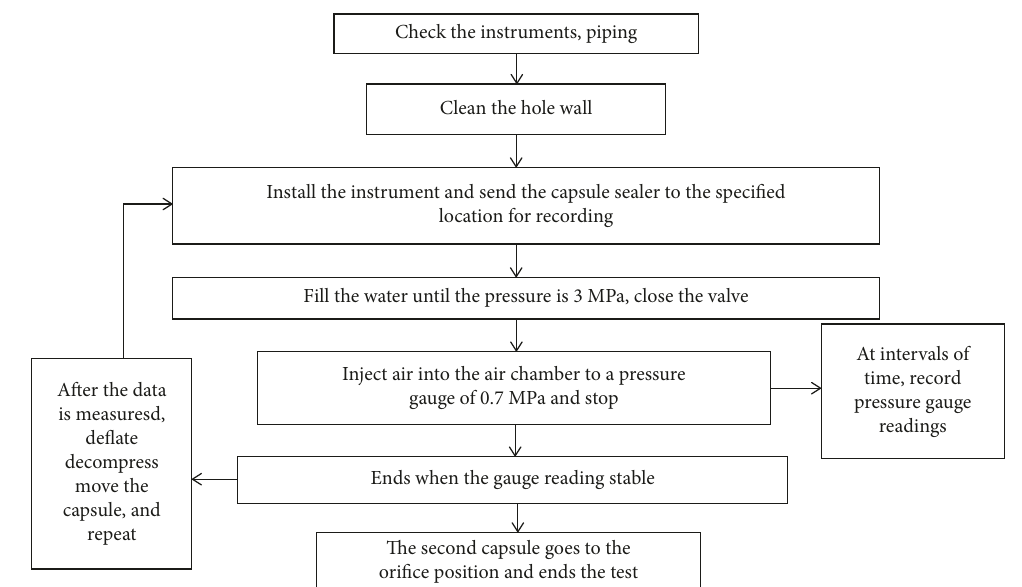
Figure 3: Flowchart of the high-pressure gas attenuation method.